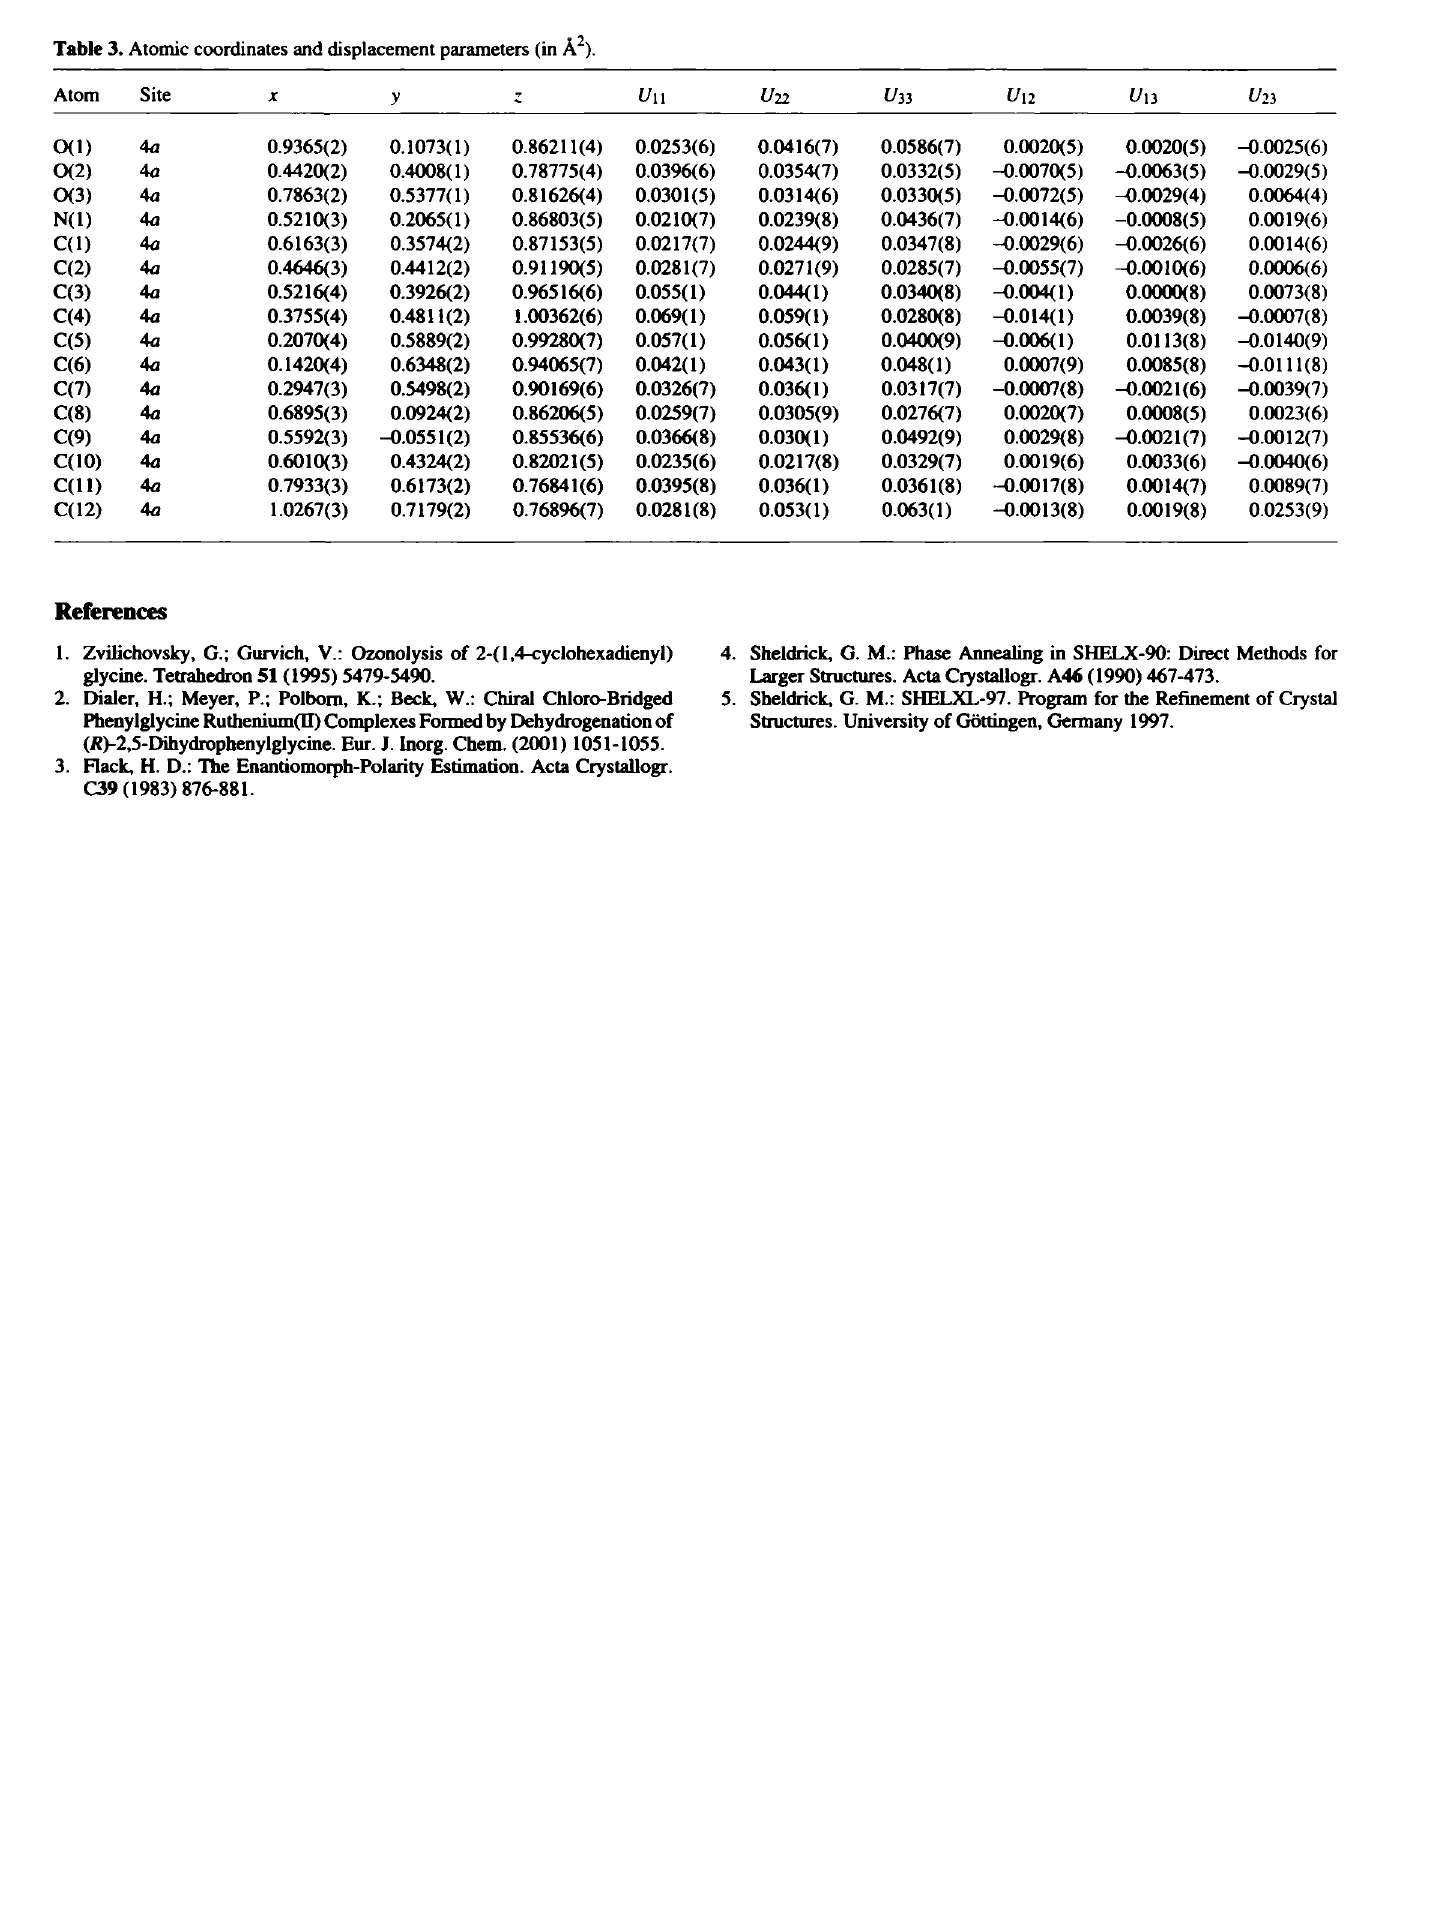
Table 3. Atomic coordinates and displacement parameters (in À 2